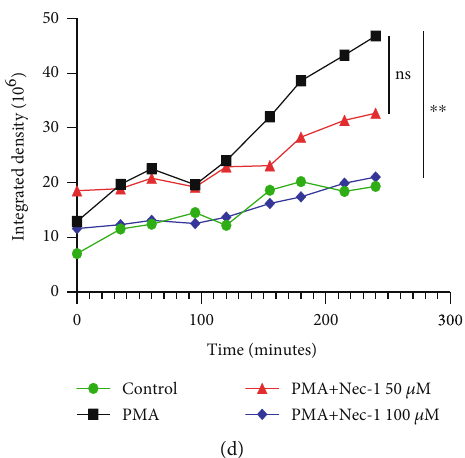
Figure 2: Nec-1 inhibited the formation of neutrophil extracellular traps (NETs) in vitro . (a) Neutrophils were cultured with phorbol 12-myristate 13-acetate (PMA) or PMA plus Nec-1 (50 μ M or 100 μ M). Representative immuno fl uorescence images of neutrophils stained using SYTOX Green (green) and Hoechst (blue) (200x). (b) Peripheral blood neutrophils were cultured with PMA or PMA plus di ff erent concentrations of Nec-1 (50 or 100 μ M). Extracellular DNA levels, which were determined via SYTOX Green staining, were detected using a microplate reader. (c) SYTOX Green-stained neutrophils stimulated with 25nM PMA or with di ff erent concentrations of Nec-1 (50 or 100 μ M) were photographed for 4h using an automatic live-cell imaging analysis system with the GFP green channel (measurement of non-transmembrane SYTOX Green). The green fi brin-like structures indicate NETs. Videos S1 – S4 show the change of untreated cells and also of cells treated with PMA (25 nM), PMA+Nec-1 (50 μ M), and PMA+Nec-1 (100 μ M), respectively. (d) The mean fl uorescence intensity of live-cell imaging pictures at di ff erent time points is presented and analysed (0-240min). The mean fl uorescence intensity of SYTOX Green at di ff erent time points was determined using ImageJ semiquantitative statistics. Values are expressed as mean ± standard error of the mean (SEM) of three independent experiments ( ∗∗∗ P < 0 : 001 and ∗∗∗∗ P < 0 : 0001